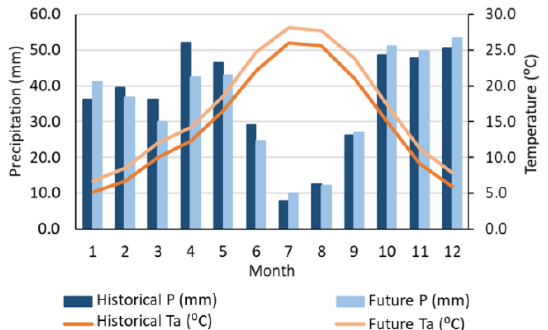
Figure 4. Monthly mean historical and future estimated climatic variables (precipitation (P; mm) and temperature (Ta; °C)). The historical (1974–2015) data were obtained from the Spain02 dataset, and the future (2016–2045) series was generated by applying the proposed methodology.